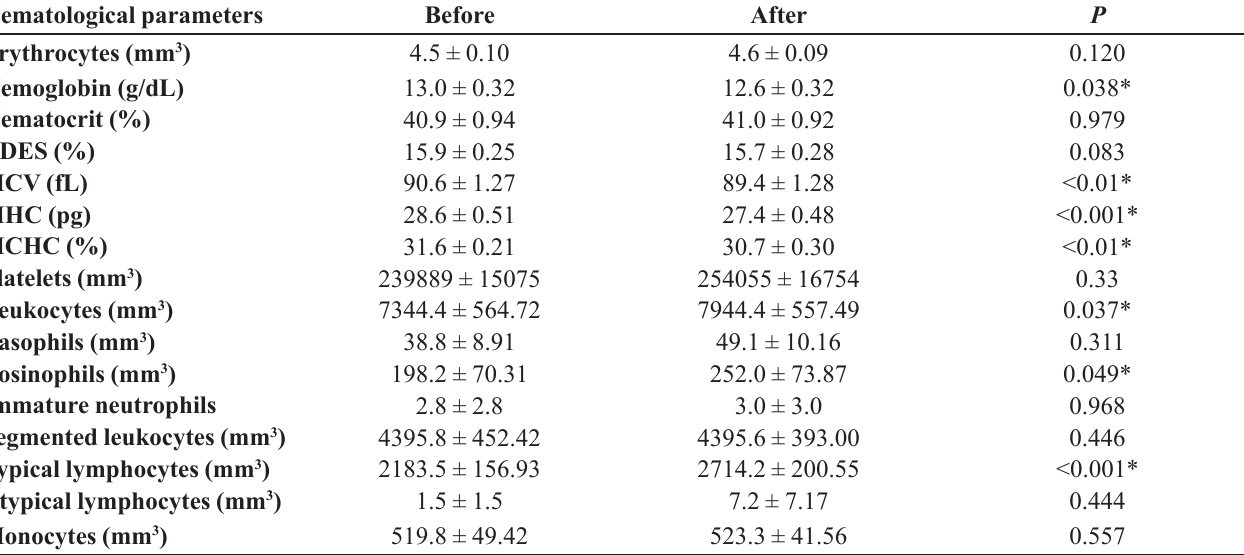
TABLE IV - Hematological parameters of diabetic patients before and after supplementation with glutamine dipeptide (mean ± standard error). Number of patients = 18 Hematological